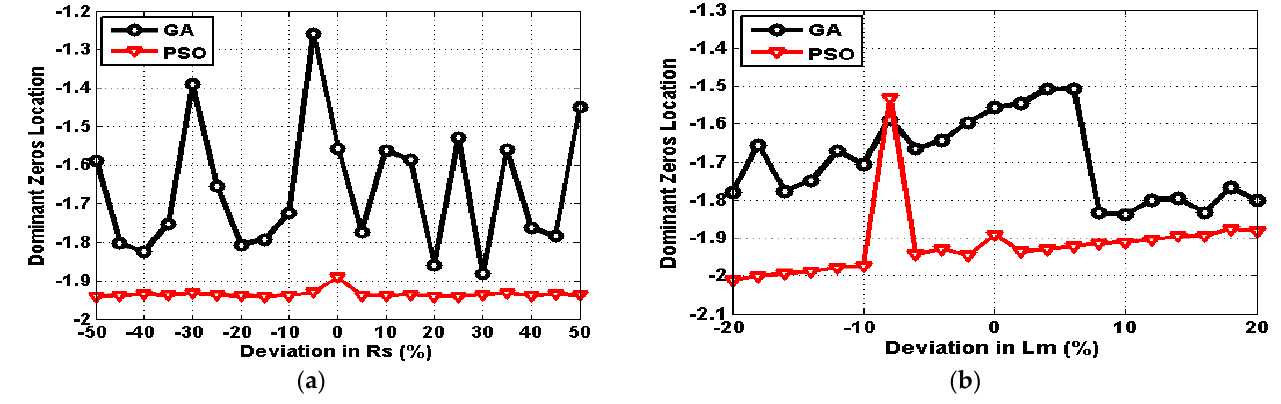
Figure 4. Optimal location of dominant zero in the regenerating mode using PSO and GA. ( a ) Under stator resistance deviation; ( b ) under magnetizing inductance deviation.